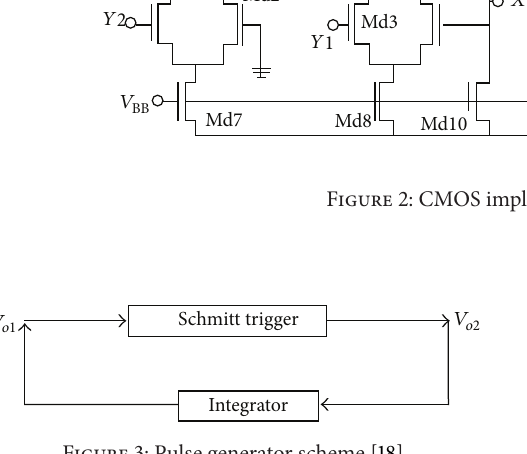
Figure 3: Pulse generator scheme [18].